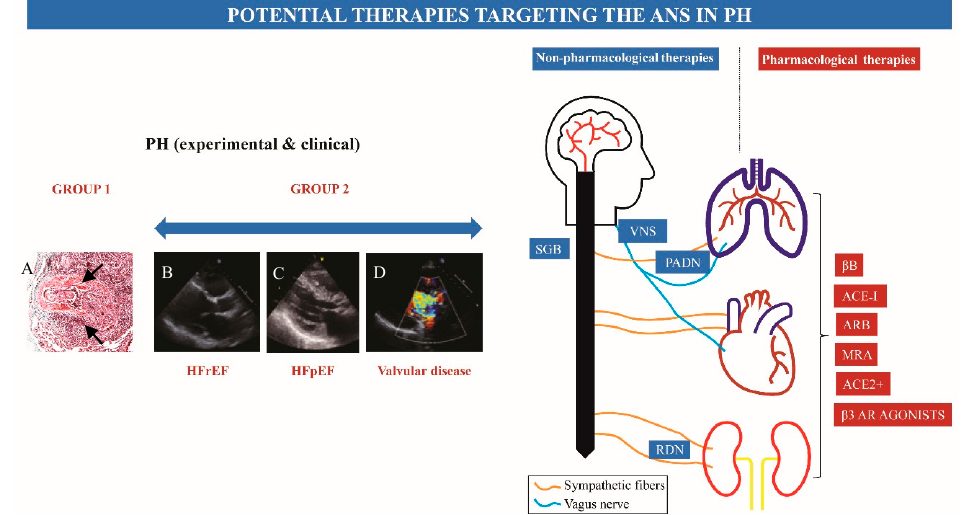
Figure 1. Schematic figure summarizing neurohormonal activation in pulmonary hypertension (PH) and pharmacologic and invasive treatments targeting the autonomic nervous system (ANS)/ renin-angiotensin-aldosterone system (RAAS) in this condition. ( A ) Microphotograph of pulmonary vascular remodeling in experimental pulmonary arterial hypertension (PAH) secondary to systemic-to-pulmonary shunt (in piglets). Black arrows point to a plexiform lesion, one of the histopathological hallmarks of pulmonary arterial hypertension (PAH); ( B – D ). Figures of parasternal long-axis transthoracic echocardiograms illustrating the spectrum of patients with PH secondary to heart failure (HF). ( B ) A patient with HF with reduced ejection fraction (secondary to dilated cardiomyopathy): ( C ) HF with preserved ejection fraction (secondary to hypertrophic cardiomyopathy); and ( D ) HF secondary to valvular heart disease (severe aortic regurgitation). ACE-I, angiotensin-converting enzyme inhibitors; ACE2 + , angiotensin-converting enzyme stimulator; AR, adrenergic receptor; ARB, angiotensin receptor blocker; β B, beta-blocker; HFpEF, heart failure with preserved ejection fraction; HFrEF, heart failure with reduced ejection fraction; MRA, mineralocorticoid receptor antagonist; PADN, pulmonary artery denervation; RDN, renal denervation; SGB, sympathetic ganglion block; VNS, vagal nerve